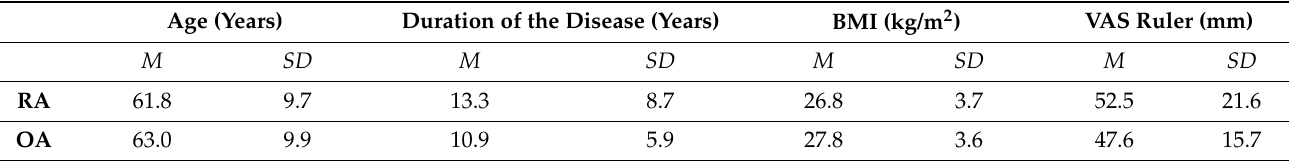
Table 1. Descriptive parameters of study groups.